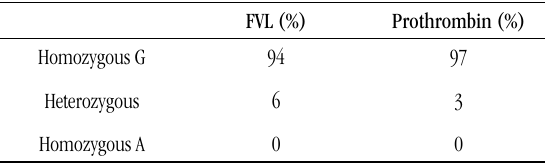
tABLE 1 – Genotypic frequency of FVL and prothrombin genotypes in the studied